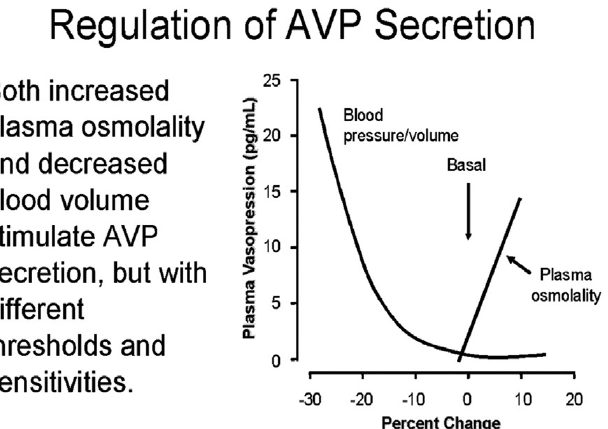
Figure 4. Graph demonstrating the progressive increase in ADH levels with worsening volume de- pletion despite the coexistence of plasma hypo − osmolality; the volume stimulus is more potent than the osmolar stimulus. This is why a volume depleted patient remains hyponatremic while drinking water. Isotonic saline infusions will eliminate the volume stimulus and allow the hypo − osmolality or hyponatremia to inhibit ADH secretion, get rid of the excess water and correct the hyponatremia. Because of the difficulty in differentiating SIADH from C/RS, we decided to test the response to isotonic saline in unequivocally diagnosed cases of SIADH and C/RSW. We performed blood volume studies by radioisotope dilution methods utilizing 51 chromium labeled red blood cells and radio-iodinated serum albumin. Two patients with SIADH had increased blood volume, low plasma renin and aldosterone levels as compared to decreased blood volume and high plasma renin and aldosterone levels in C/RSW, which along with clinical and laboratory findings collectively strengthened the diagnoses of SI- ADH and C/RSW, respectively. Isotonic saline infusions in the 2 patients with SIADH failed to induce excretion of dilute urines or correct the hyponatremia as compared to diluting the urine after 13 h of isotonic saline infusions and correcting the hyponatremia within 48 h in the patient with C/RSW, Figure 3a,b [9,26]. These studies are consistent with previous reports that patients with SIADH do not dilute their urine or correct their hypo- natremia by isotonic saline infusions as compared to diluting their urine and correcting the hyponatremia in C/RSW. 4. Utilization of FEurate and Response to Isotonic Saline in Evaluation of Hypo- natremic Patients We decided to determine whether hyponatremic patients with increased FEurate >11% diluted their urine and corrected their hyponatremia with infusions of isotonic sa- line and determined FEurate before and after correction of their hyponatremia in 62 hy- ponatremic patients recruited from the general medical wards of the hospital [17]. Ac- cording to the algorithm presented in Figure 2, 17 (27%) had SIADH based on normaliza- tion of a previously increased FEurate after correcting their hyponatremia in 5 and 17 fail- ing to dilute their urine or correct their hyponatremia after receiving ample volumes of isotonic saline. Twenty four (38%) had C/RSW. Twelve had persistently increased FEurate after correcting their hyponatremia, 19 had isotonic saline-induced dilute urines with 10 requiring infusions of D5W to prevent too rapid correction of their hyponatremia and osmotic demyelination syndrome [36]. Six of the 19 patients who had isotonic saline-in- duced dilute urines also had persistently increased FEurate after correction of their hypo- natremia. Twenty one of the 24 patients did not have clinical evidence of cerebral disease to support our proposal to change cerebral to renal salt wasting (RSW) [37]. This change in nomenclature is extremely important because many C/RSW patients would otherwise not consider renal salt wasting in the absence of cerebral disease. We will thus use the